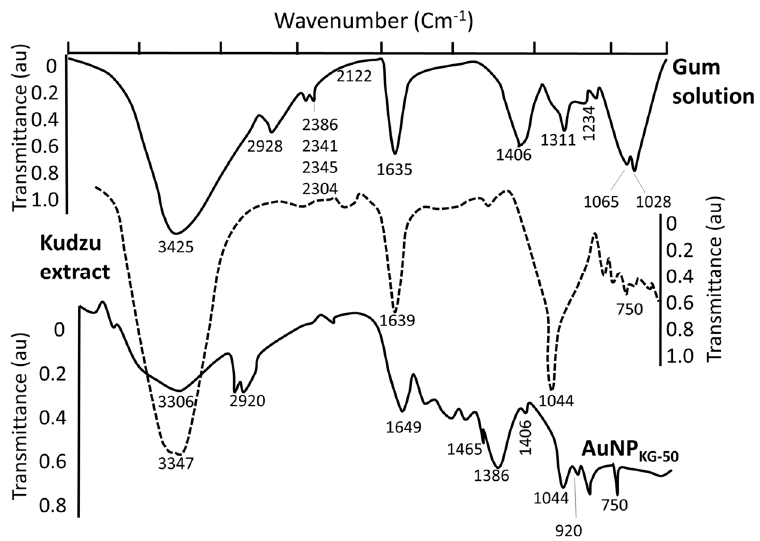
Figure 2. Typical FTIR spectra for AuNP KG , kudzu extracts, and gum solution.